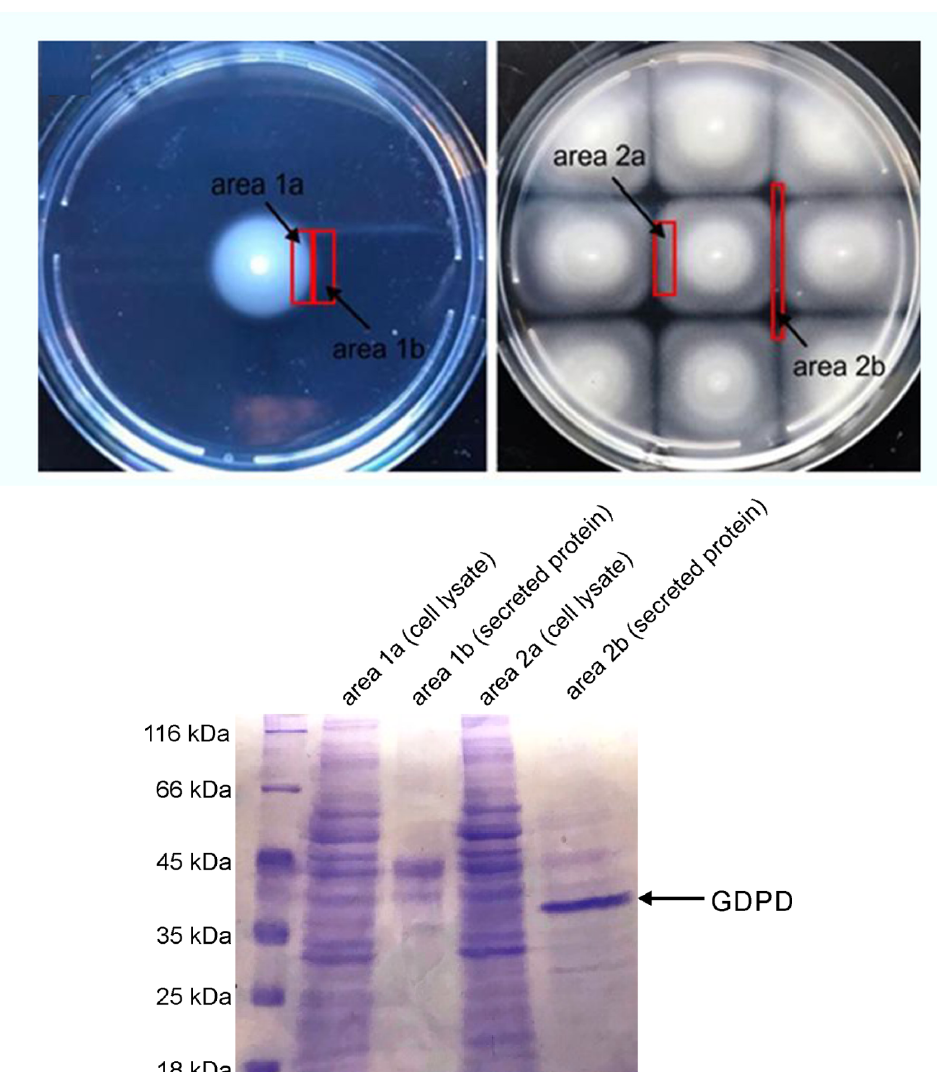
Figure 4. Secretion of proteins by colonies of M. algicola DG893. Upper left: Zones sampled (1a and 1b) for non-interacting colonies. Upper right: Zones sampled (2a and 2b) for interacting colonies. Lower: 12% SDS-PAGE separation of proteins from cell lysates or secreted proteins from indicated areas produced by M. algicola . Migration position of periplasmic glycerophosphoryl diester phosphodiesterase (RefSeq WP_007154889.1; GenBank EDM46611.1) is indicated with an ar- row.